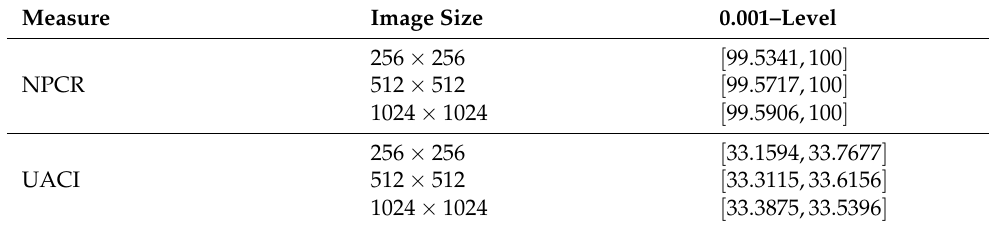
Table 6. Acceptance intervals for the null hypothesis with significance level α = 0.001